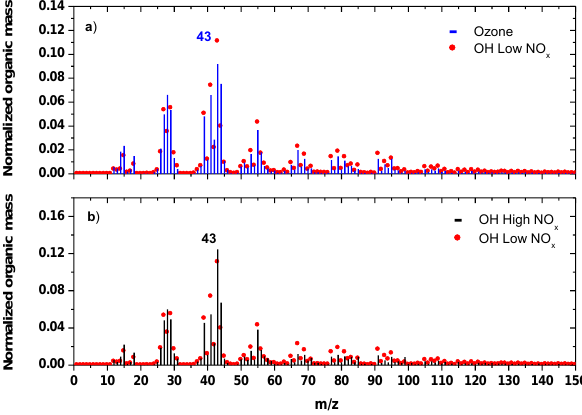
Figure 4. Comparison of the organic mass spectra of the β - caryophyllene SOA produced from the three reaction systems: (a) from ozonolysis and OH at low NO x ( θ = 12 ◦ ) and (b) from OH at high and low NO x ( θ = 15 ◦